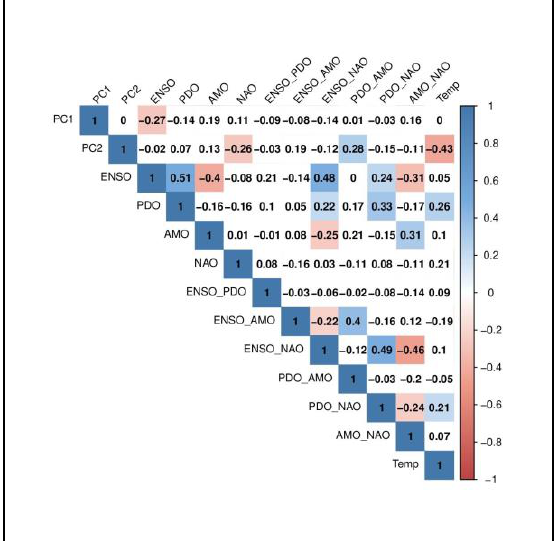
Figure 6. Pearson correlation coefficients of the leading (PC1) and second (PC2) principal components of the entire data with climate indices. Values in white are not significant at the 5% level. Double labels, for example, ENSO – NAO, denote interactions between ENSO and NAO. Temp denotes the global annual temperature time series.